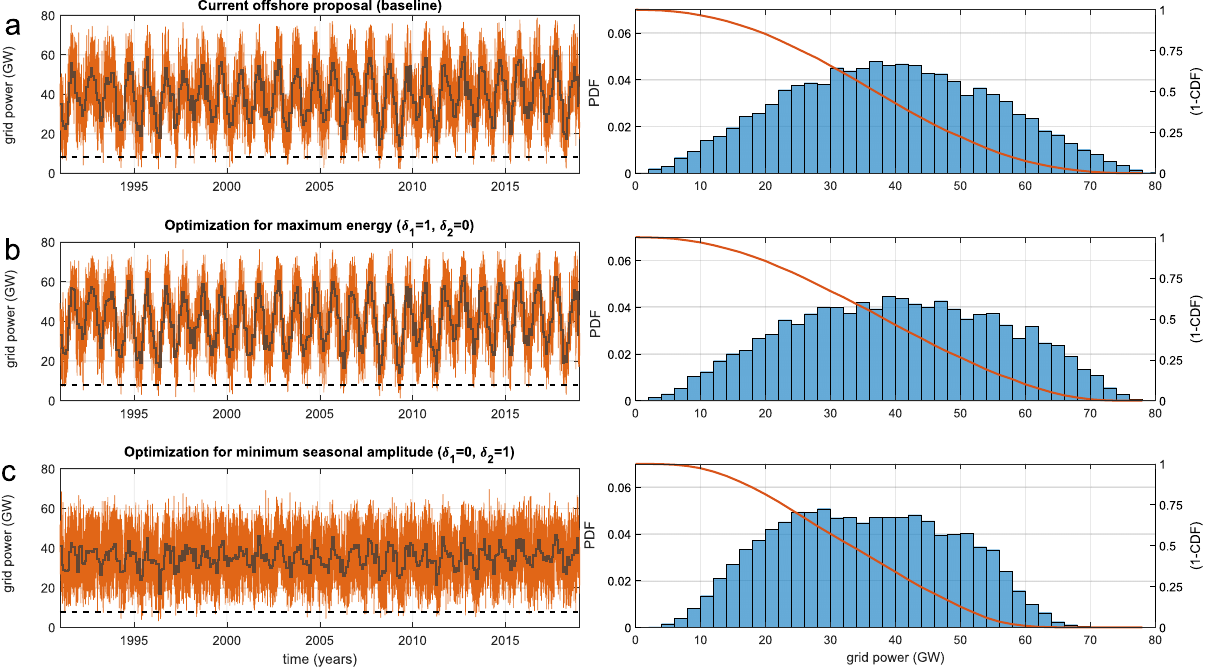
Figure 6. Results of the offshore grid simulations. The left-hand panels represent the time series of P grid for 30 years (GW units). The thin orange line represents daily averages computed from hourly data and the thicker brown line represents monthly averages. The right-hand panels indicate the correspondent histogram (PDF, blue bars) and cumulative distributions (1-CDF, orange line) of P grid . The rows indicate ( a ) the baseline simulation including all offshore wind parks currently proposed at IBAMA, ( b ) GA optimization for maximum power generation, and ( c ) GA optimization for the minimum seasonal amplitude of P grid